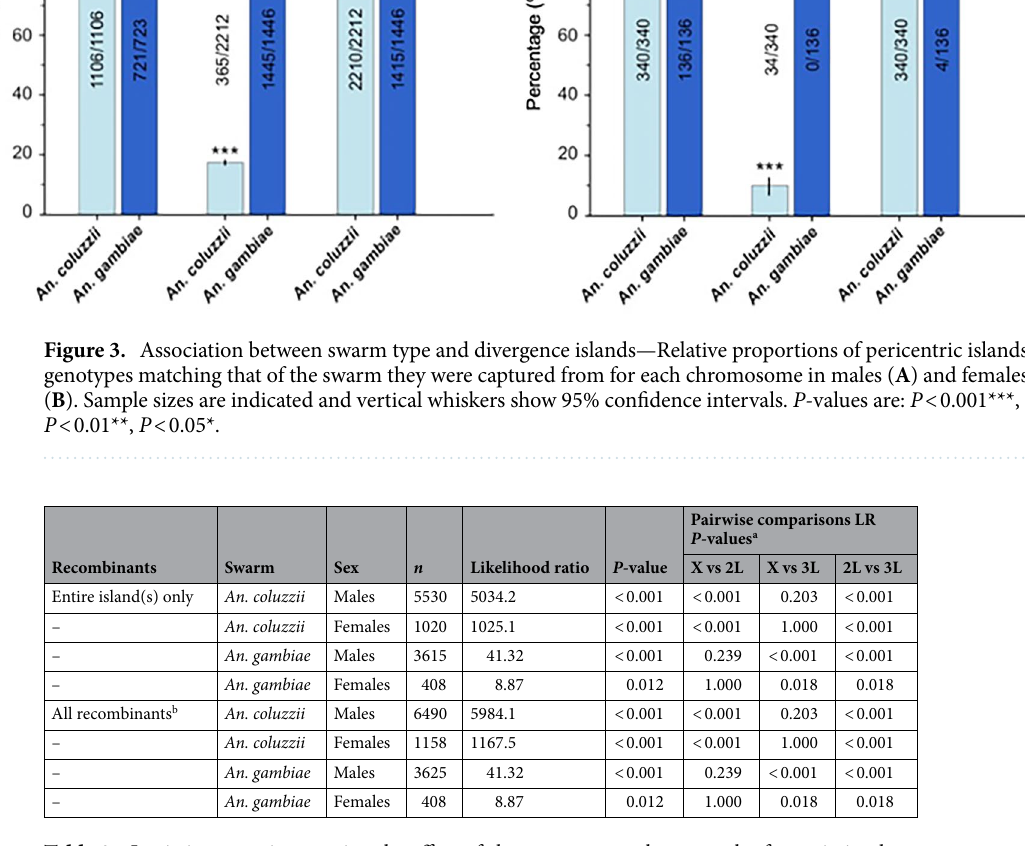
Table 3. Logistic regressions testing the effect of chromosome on the strength of association between pericentromeric island genotypes and swarm type. a Recombinant chromosomes included those characterized by one or two entire heterospecific divergence islands, and recombinants with parts of or recombined heterospecific island(s) leading to identical results. b The P -values of likelihood-ratio (LR) tests on odds ratios generated by the logistic regression. All pairwise comparisons were also tested using Fisher–Irwin tests and N − 1 Chi-square tests robust to low cell counts yielding comparable results (see “Methods”).